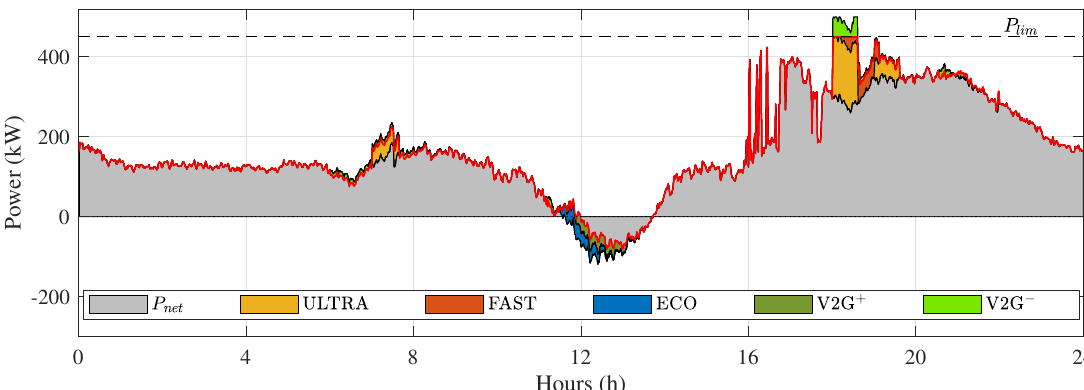
Figure 8. Power flow of charging modes and the liquid power delivered to the PCC, highlighting the external grid power ( P grid ) with the red